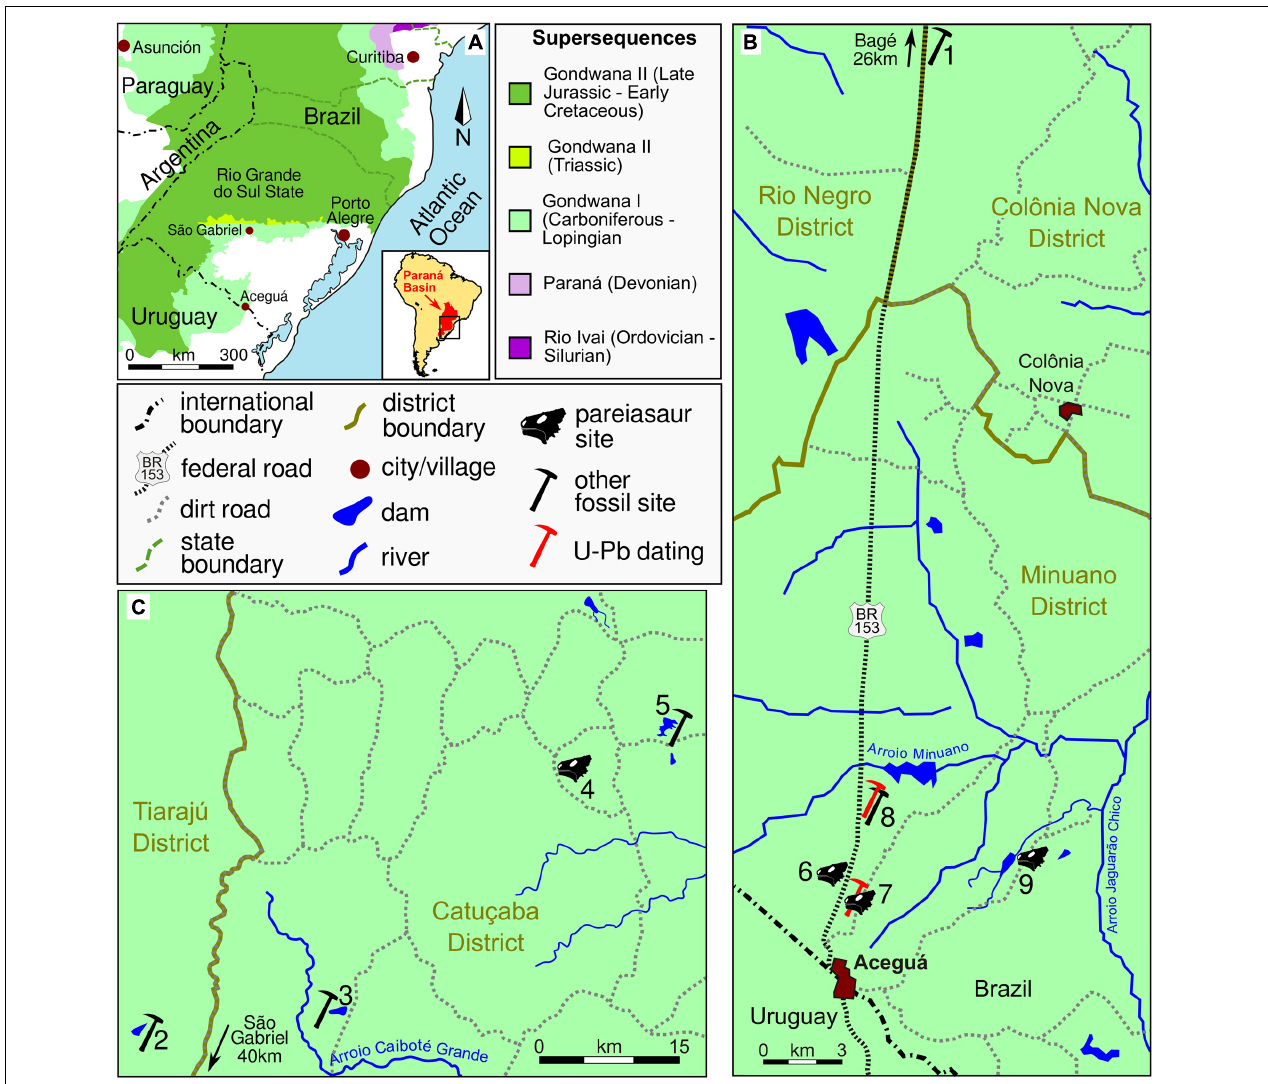
FIGURE 1 | Provenance of Rio do Rasto Formation pareiasaurs and other fossils in Rio Grande do Sul State. (A) Paraná Basin in southern Brazil. The Rio do Rasto Formation is included in the Gondwana I Supersequence. (B) Rio do Rasto sites in the Aceguá Municipality. (C) Rio do Rasto sites in the São Gabriel Municipality. (1) Coxilha Grande Farm, type locality of the temnospondyl Bageherpeton longignathus (Dias and Barberena, 2001) and the chondrichthyan Xenacanthus santosi (Würdig-Maciel, 1975); (2) Capão Alto Farm, archosauromorphs, type locality of Tiarajudens eccentricus and Triodus richterae (Cisneros et al., 2011; Martinelli et al., 2017; Pauliv et al., 2017); (3) ‘Coprolândia,’ coprolite-rich site (Dentzien-Dias et al., 2012); (4) Unnamed farm property of Modesto Spencer Fagundes (= ‘Posto Queimado’), MCP 4263PV, dinocephalians, temnospondyls, chondrichthyans and bony fishes (Langer, 2000; Malabarba et al., 2003; Cisneros et al., 2005); (5) Boqueirão Farm, type locality of the dinocephalian Pampaphoneus biccai , the dicynodont Rastodon procurvidens , and the temnospondyl Konzhukovia sangabrielensis (Cisneros et al., 2012; Boos et al., 2016; Pacheco et al., 2017); (6) BR-153 Highway, km 665.4, west side of the road, type locality of Provelosaurus americanus , holotype UFRGS-PV-0231-P, UFRGS-PV-0232-P, *UFRGS-PV-0358-P and *UFRGS-PV-0376-P (Araújo, 1985b); (7) BR-153 Highway, km 666, east side of the road, UFRGS-PV-0233-P (Araújo, 1985b), fish remains and U-Pb dating (Rocha-Campos et al., 2019); (8) BR-153 Highway, Km 659.5, east side of the road, lungfish burrow and U-Pb dating (Francischini et al., 2018); (9) Santo Antônio Farm, *UFRGS-PV-0359-P. *New Provelosaurus americanus specimens. Supersequences follow Milani et al. (2007).